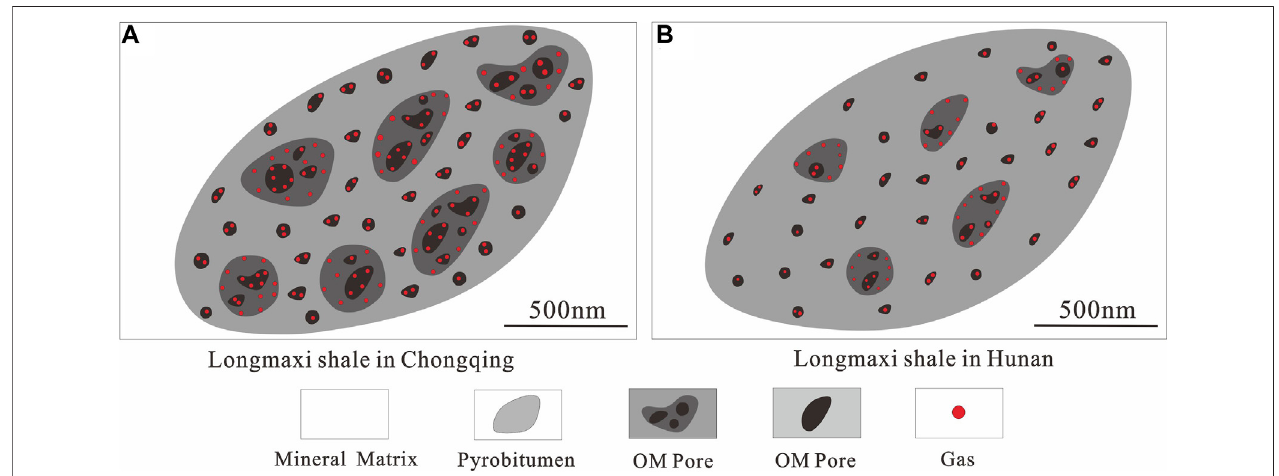
FIGURE 11 | Gas accumulation and OM pore structure model of the Longmaxi shale in Chongqing and Hunan. (A) Abundant large OM pores with amount of gas were found in the Longmaxi shale in Chongqing; (B) Few OM pores and little gas were found in the Longmaxi shale in Hunan.